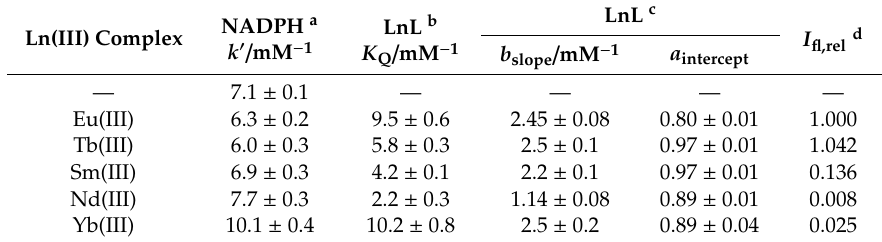
= I / I = 1–10 − k (cid:48) × cNADPH . b Eq. I fl,rel fl fl,max / I = a − b × c d Relative value calculated with I fl,LnL NADPH .